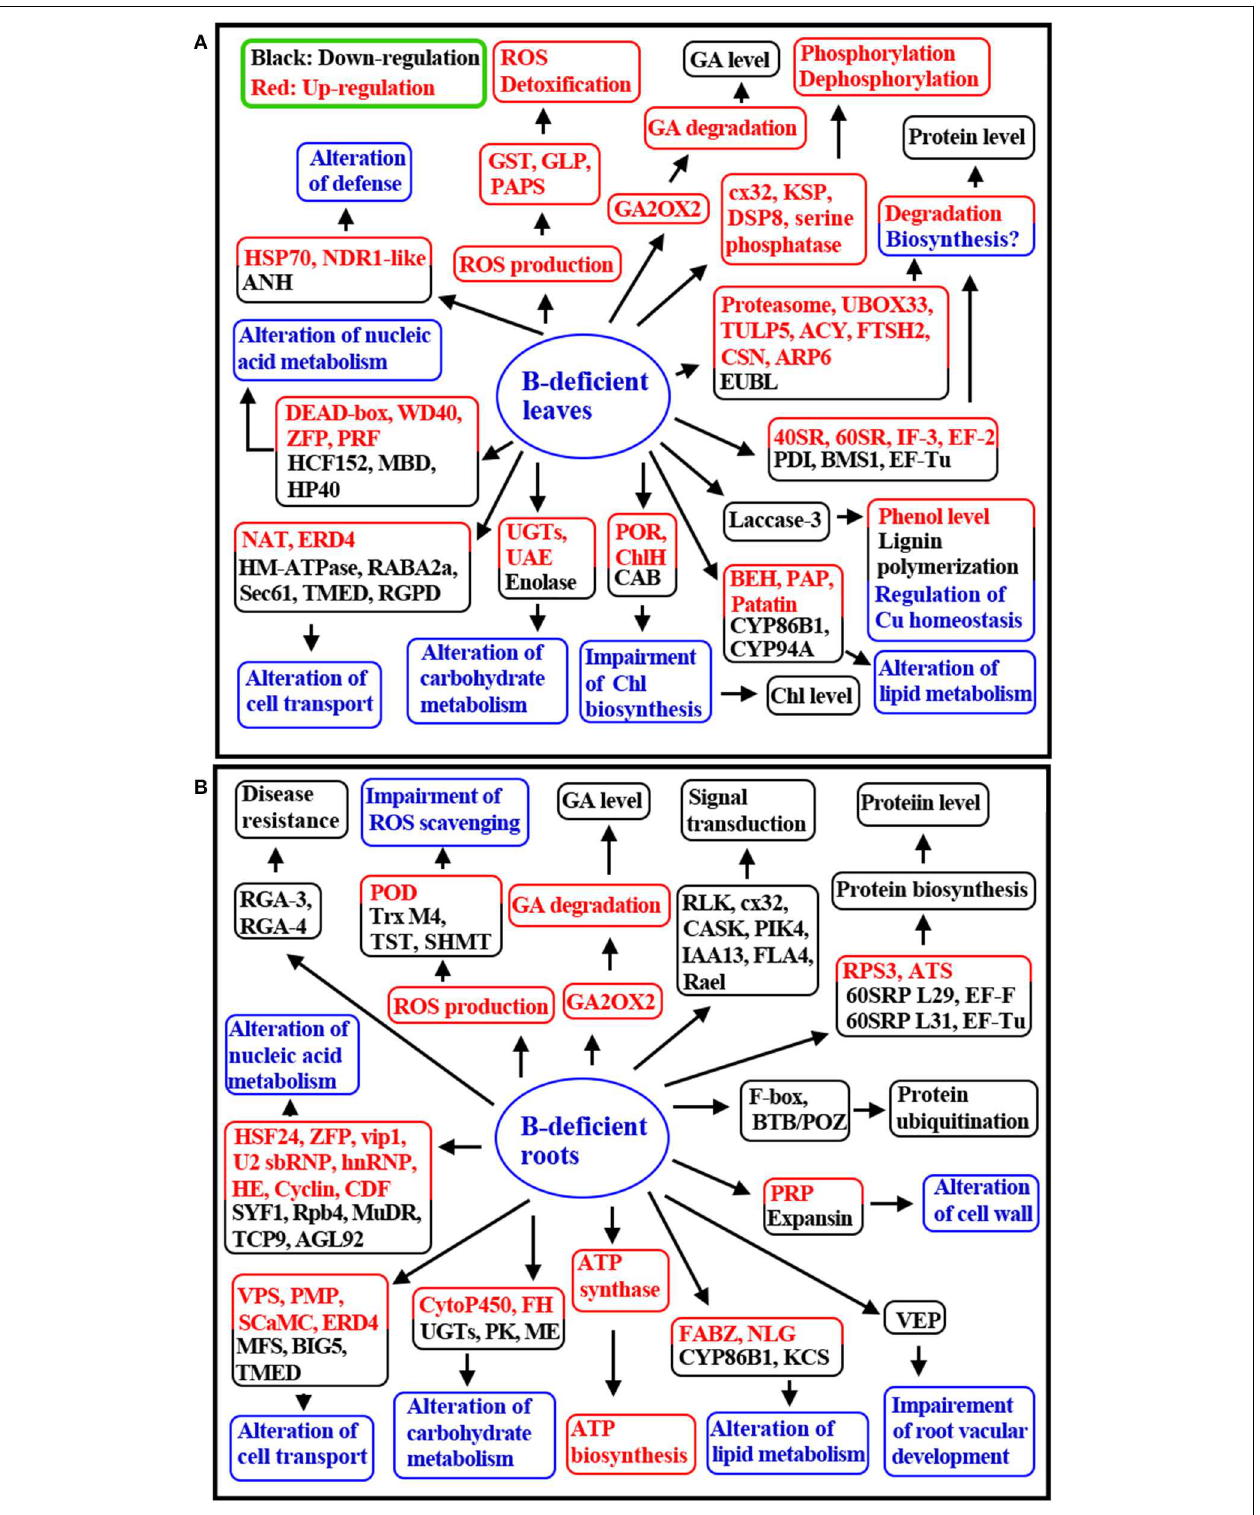
FIGURE 2 | A proposed model for the responses of C. sinensis leaves (A) and roots (B) to B-deficiency. 40SRP, 40S ribosomal protein; 60SRP, 60S ribosomal protein; ACY, Aminoacylase; ANH, Adenine nucleotide α hydrolases-like superfamily protein; ARP6, Auxin-resistance protein 6; ATS,